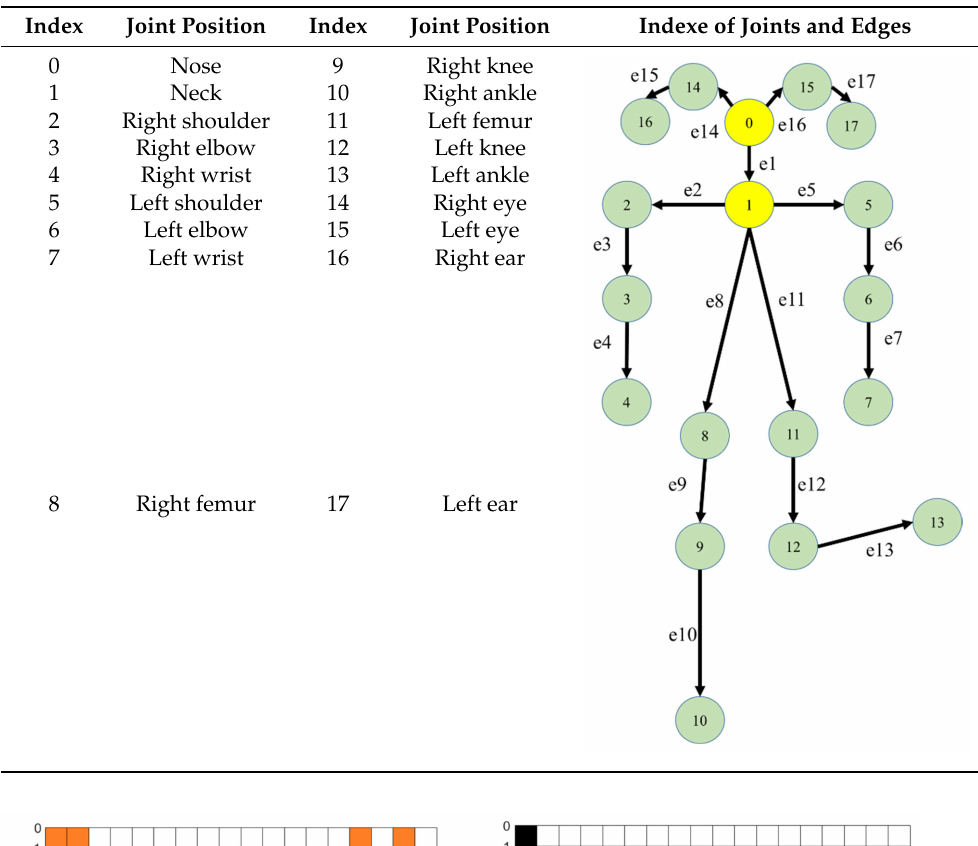
Table 2. The indexes and positions of the joints and edges for the skeletal data.